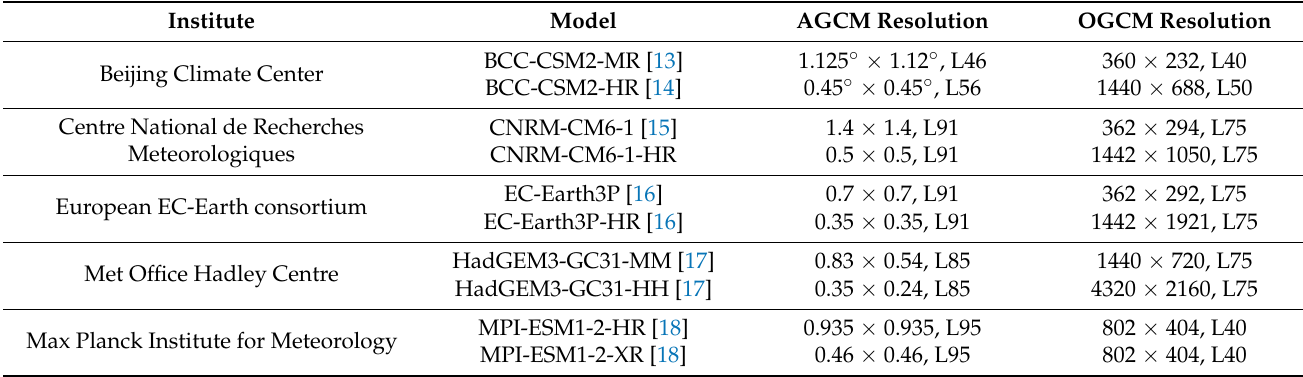
Table 1. Details of eight climate/earth system models of CMIP6 models used in the study, including the horizontal resolution (grids) and vertical